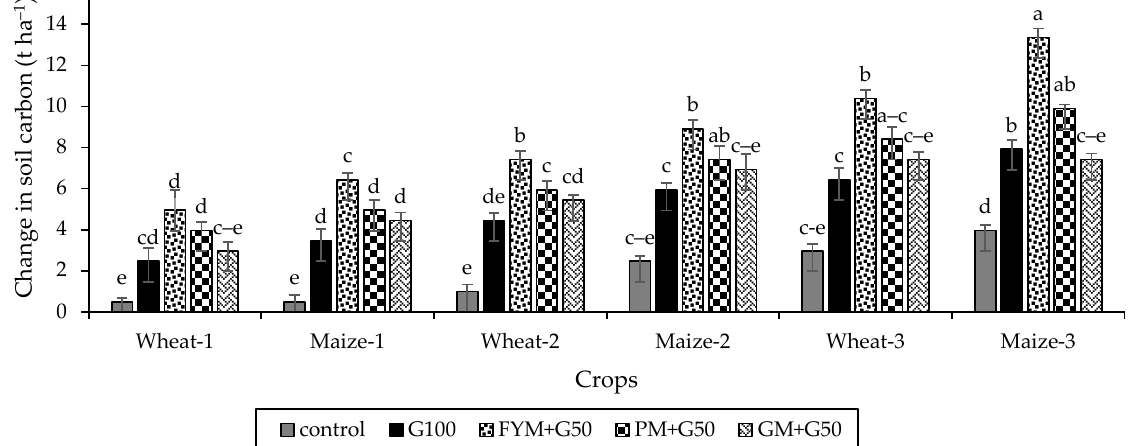
Figure 8. Carbon sequestration in freshly reclaimed marginally salt-affected soils during the wheat– maize crops rotation system. Error bars represent the standard error ( n = 3). Different letters indicate statistical difference (LSD, p < 0.05).